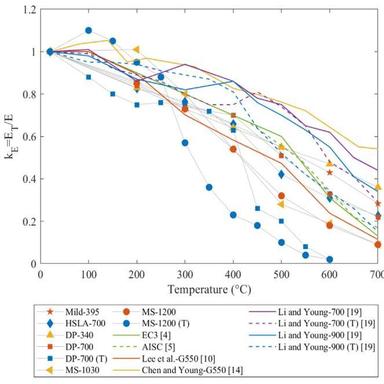
Comparison of elastic modulus (transient-state test results are marked with 'T').